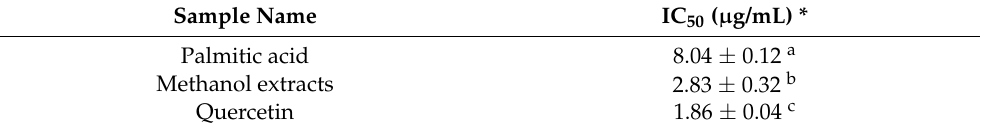
Table 3. IC 50 of Palmitic acid.